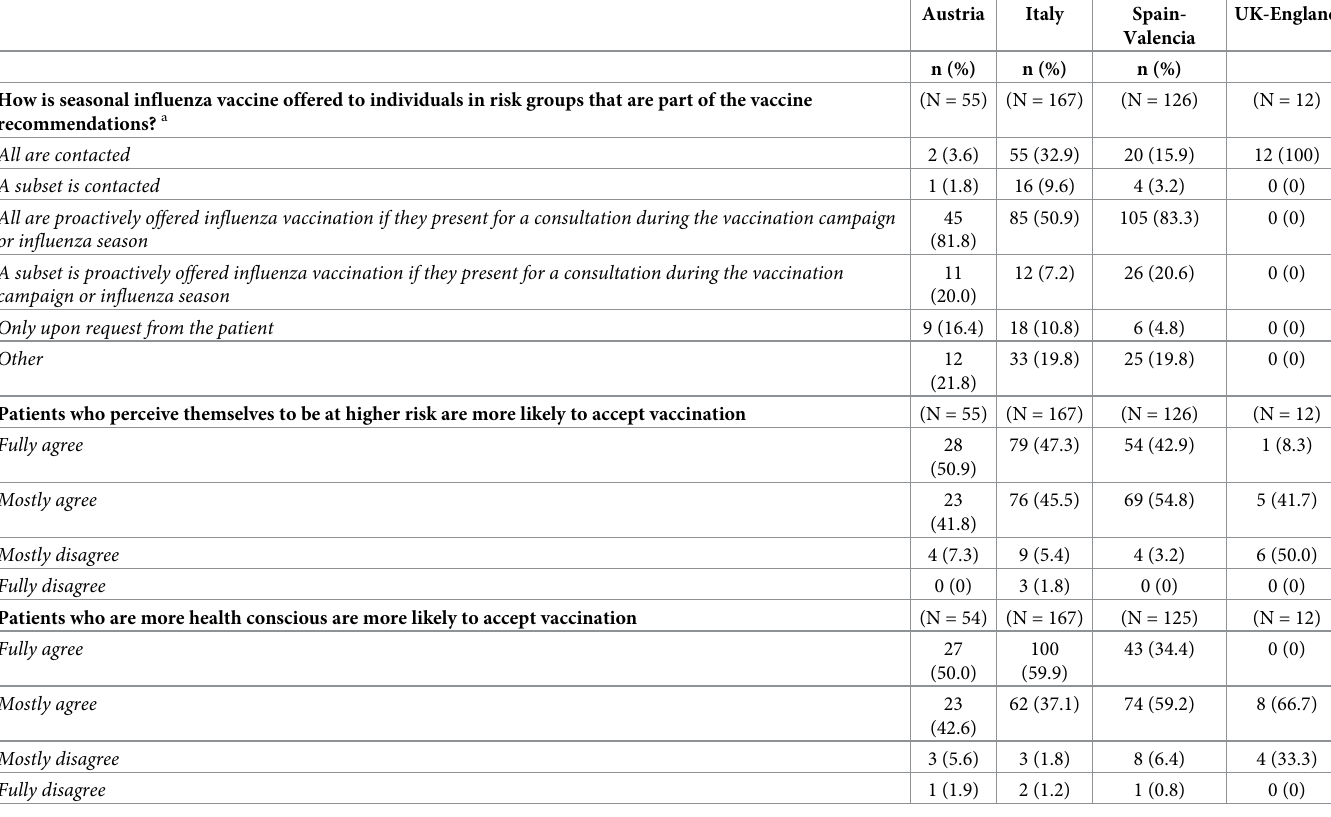
Table 3. Description of how seasonal influenza vaccine is offered to individuals in risk groups that are part of the vaccine recommendations, in 2019/2020, by